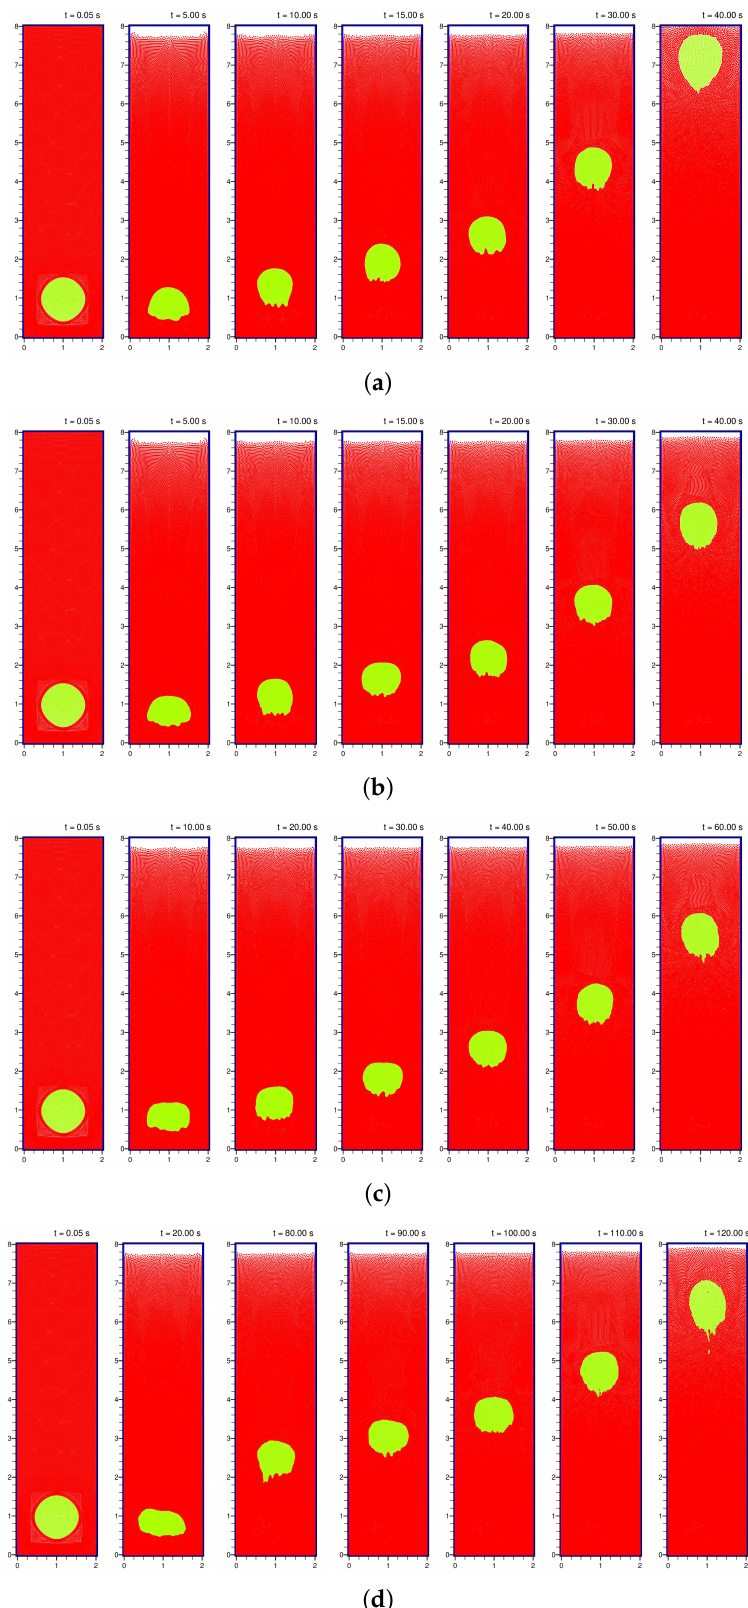
Figure 6. The evolution of one rising bubble with density ratio ρ g 0.55 ( d ),